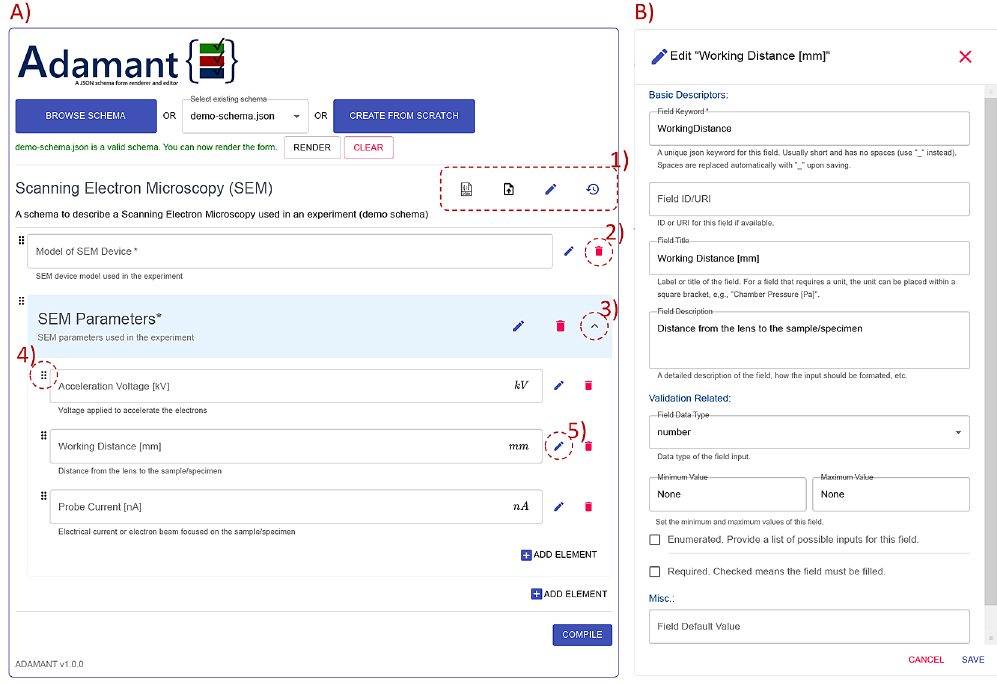
Figure 3. Overview of the Adamant UI with a rendered web-form based on the schema in Listing 1 as an example. (A) Main corpus of the UI; (1) from left to right: JSON schema viewer, auto-populate form, edit schema description, revert all changes; (2) remove form field; (3) collapse or expand the field container; (4) field drag handle; (5)editfielddescription and(B)fieldeditingpanel(asapop-upontopofthemainUI)triggeredbyclicking(5)theedit button. UI, user interface; JSON, JavaScript Object